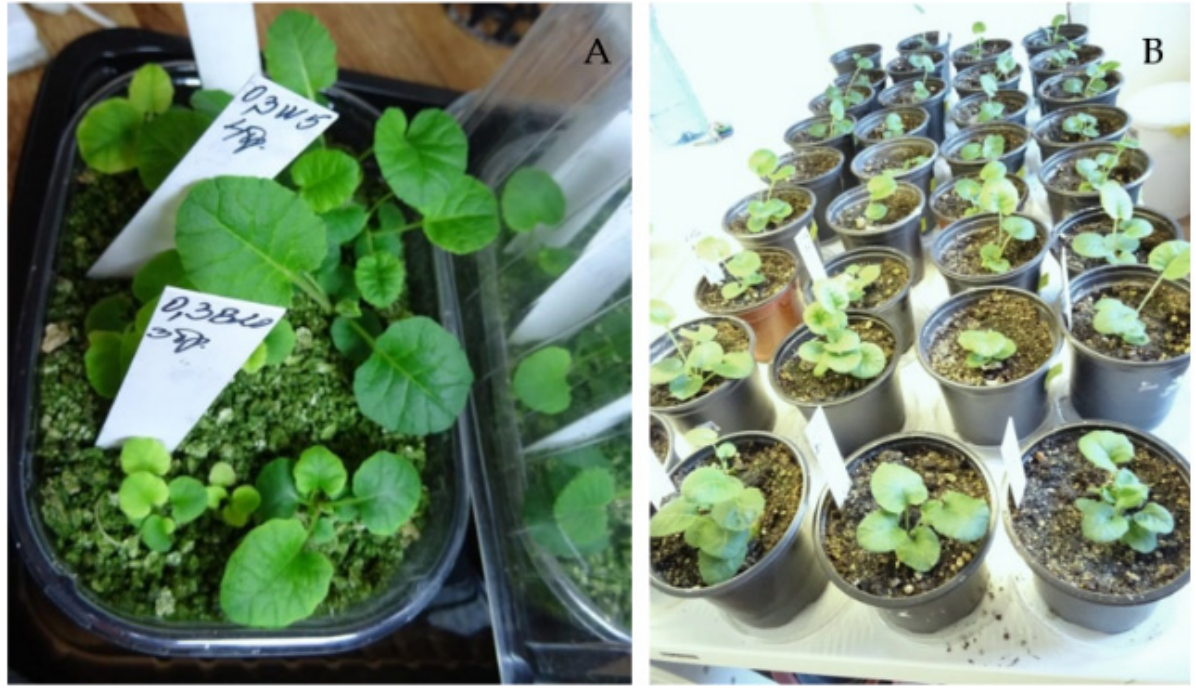
Figure 4. Plant adaptation of P. veris and growth in the phytotron: ( A ) in vermiculite; ( B ) in soil mixture.